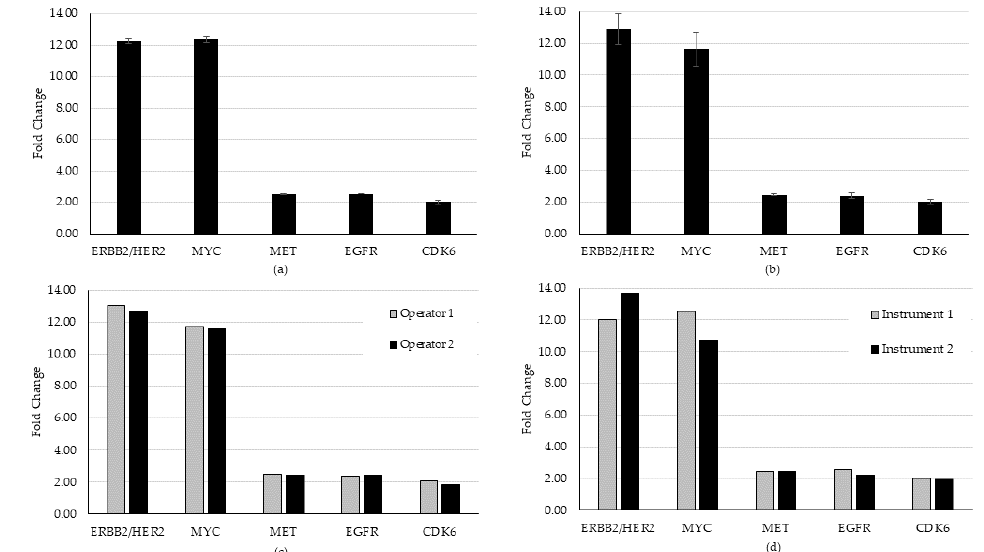
Figure 4. Repeatability and intermediate precision study results for the CNA variant type. ( a ) Re- peatability, ( b ) inter-day, ( c ) inter-operator, and ( d ) inter-instrument variability were evaluated using two contrived specimens representing five unique amplification events. Overall, the study demon- strated acceptable consistency in the detection of both the CNA and fusion/exon-skipping variant types in biologically relevant